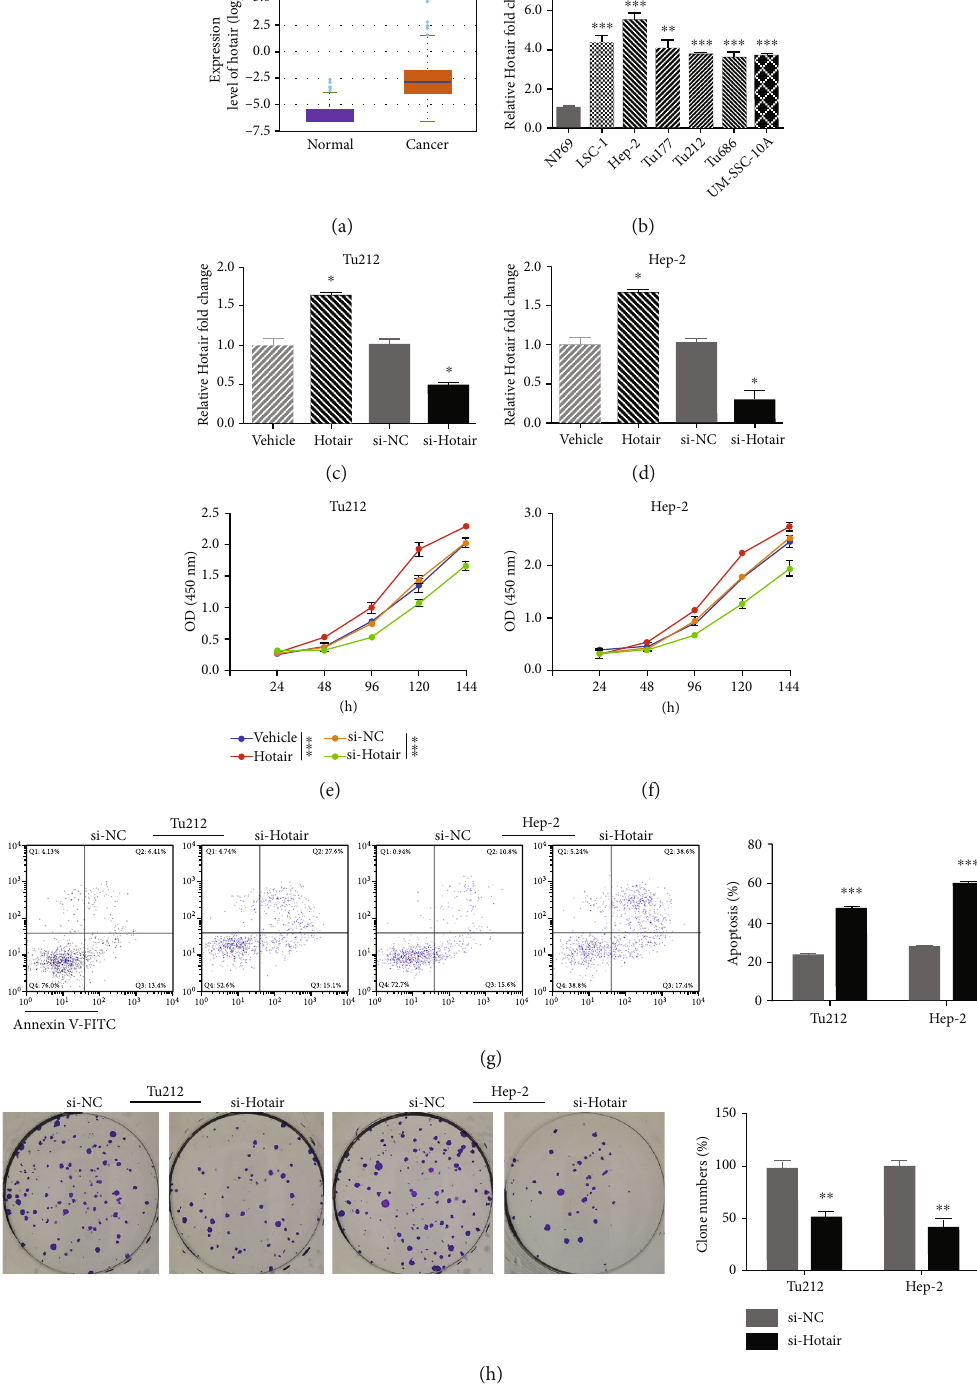
Figure 1: Hotair is frequently overexpressed in LSCC and mediates cell growth and apoptosis in LSCC cells. (a) The expression level of Hotair in HNSC tissues and normal tissues. (b) The relative expression of Hotair in six LSCC cell lines (LSC-1, Hep-2, Tu177, Tu212, Tu686, and UM-SSC-10A) and human nasopharyngeal epithelial cell line (NP69) analyzed by qRT-PCR. The relative expression of Hotair after Hotair overexpression and knockdown in (c) Tu212 and (d) Hep-2 cells analyzed by qRT-PCR. The cell viability after Hotair overexpression or knockdown in (e) Tu212 and (f) Hep-2 cells analyzed by CCK8. (g) The apoptosis after Hotair knockdown in Tu212 and Hep-2 cells. (h) The colony formation after Hotair knockdown in Tu212 and Hep-2 cells. Data are mean ± SD of at least three independent experiments; ∗ p < 0 : 05 ; ∗∗ p < 0 : 01 ; ∗∗∗ p < 0 : 001